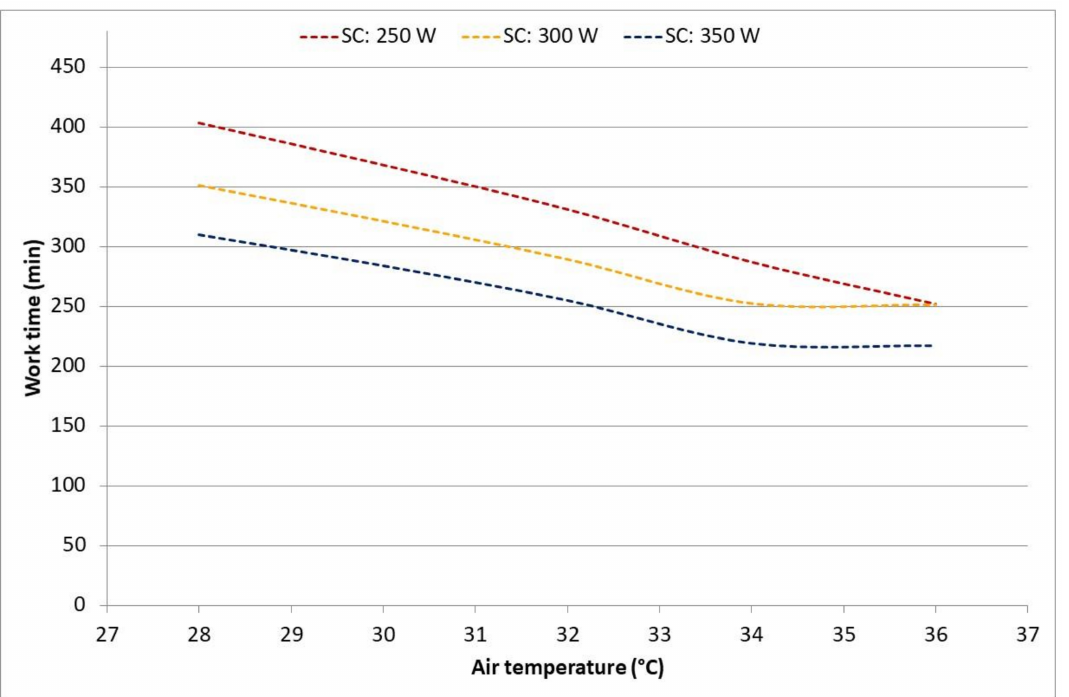
Figure 6. Expected duration limited exposure for sugarcane cutters at various activity levels based on water loss (criterion D wl,lim < 5%) in a fictive high humidity